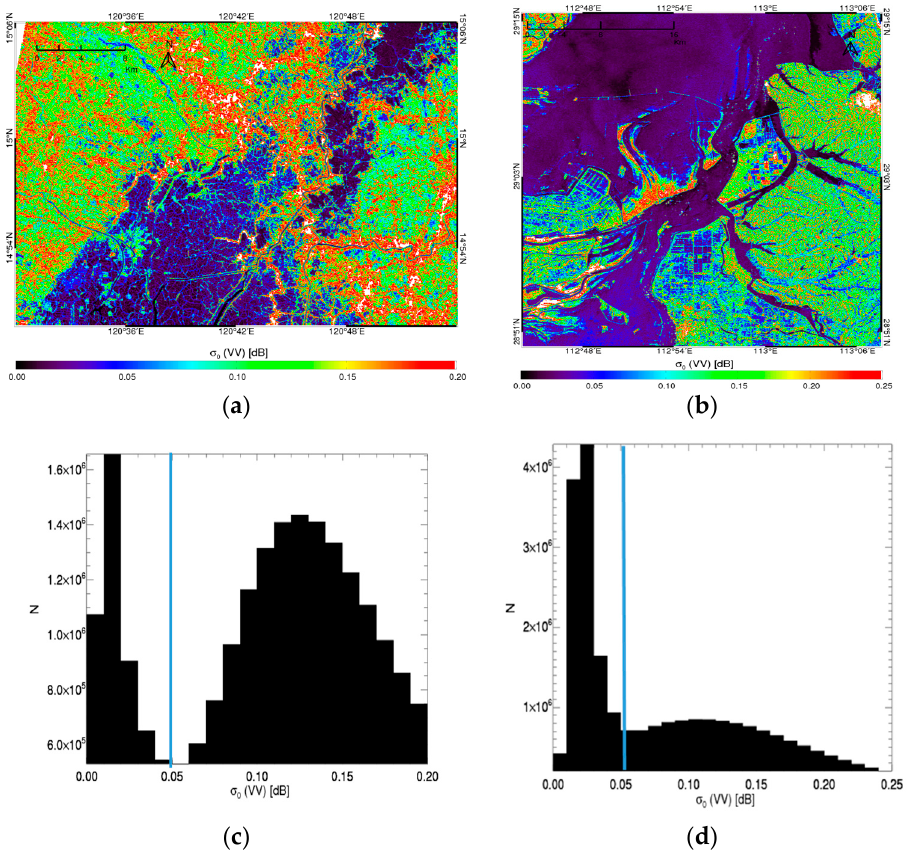
Figure 8. Backscattering coefficient images of VV-polarized SENTINEL-1A data ( a ) on 25 October 2015